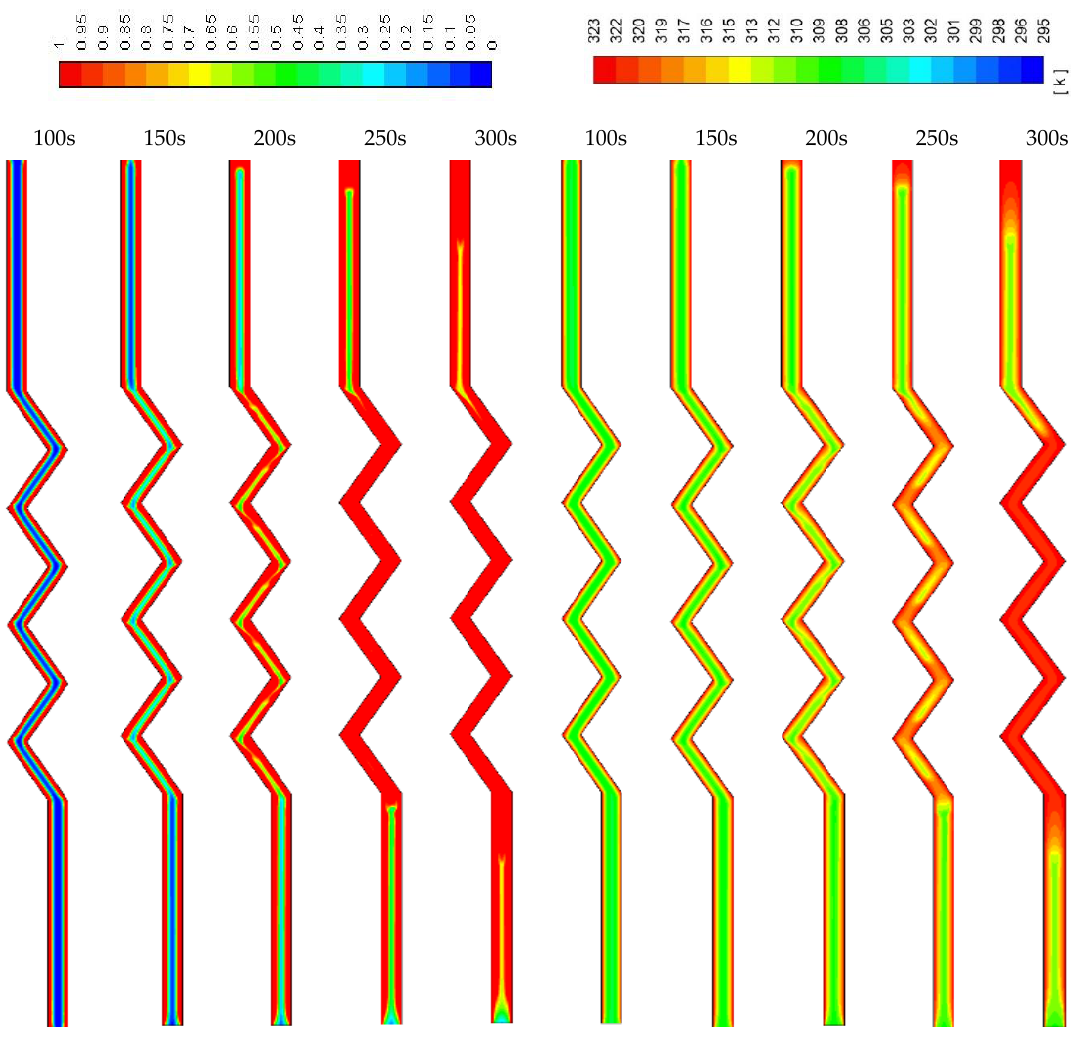
Figure 11. Contours of the liquid-fraction and temperature during the melting process for the standard width (0.9 cm) in the vertical corrugated channel.